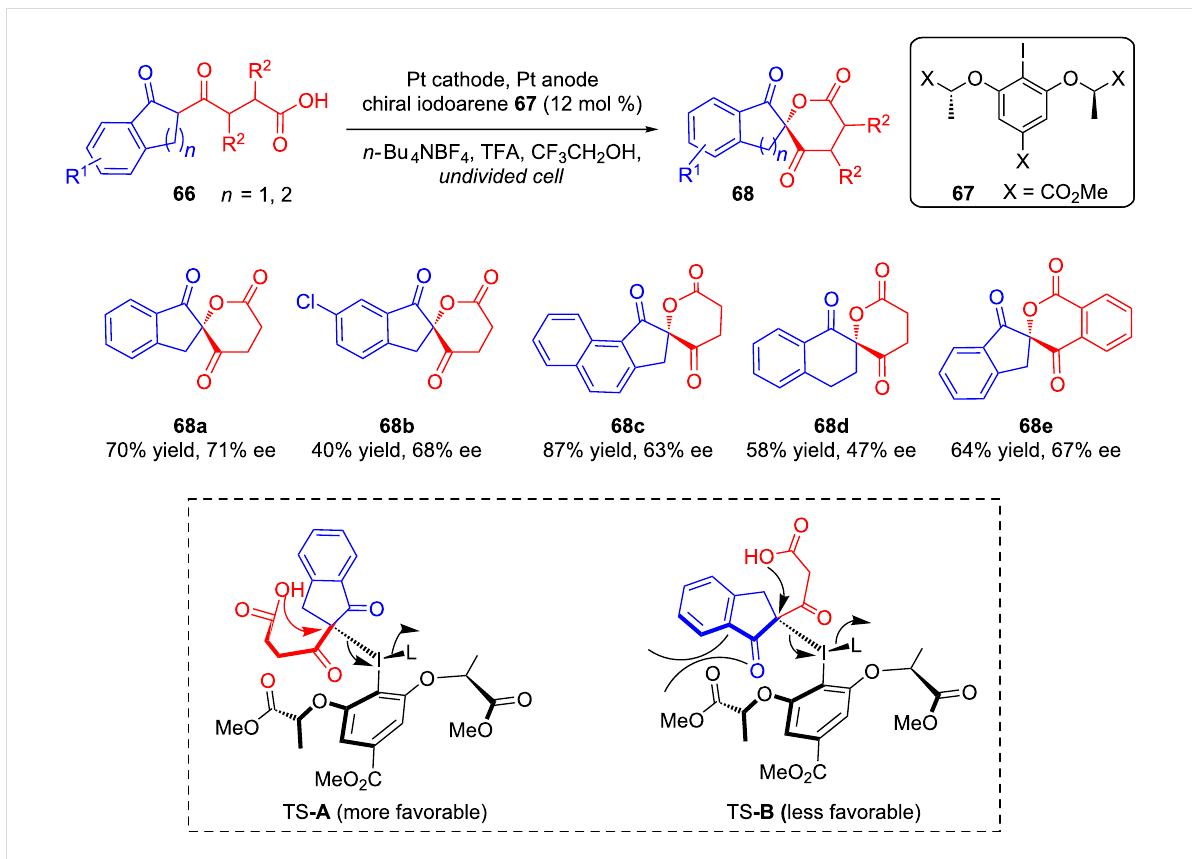
Scheme 26: Chiral iodoarene-mediated asymmetric electrochemical